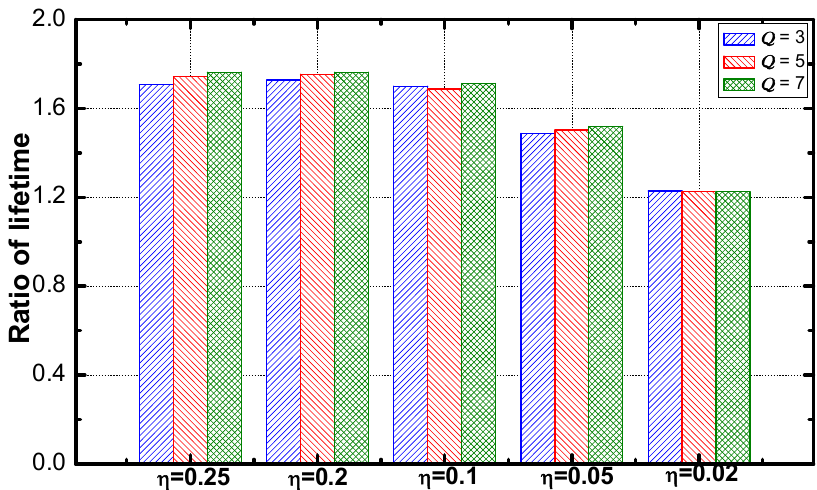
Figure 12. The ratio of lifetime vs. η .